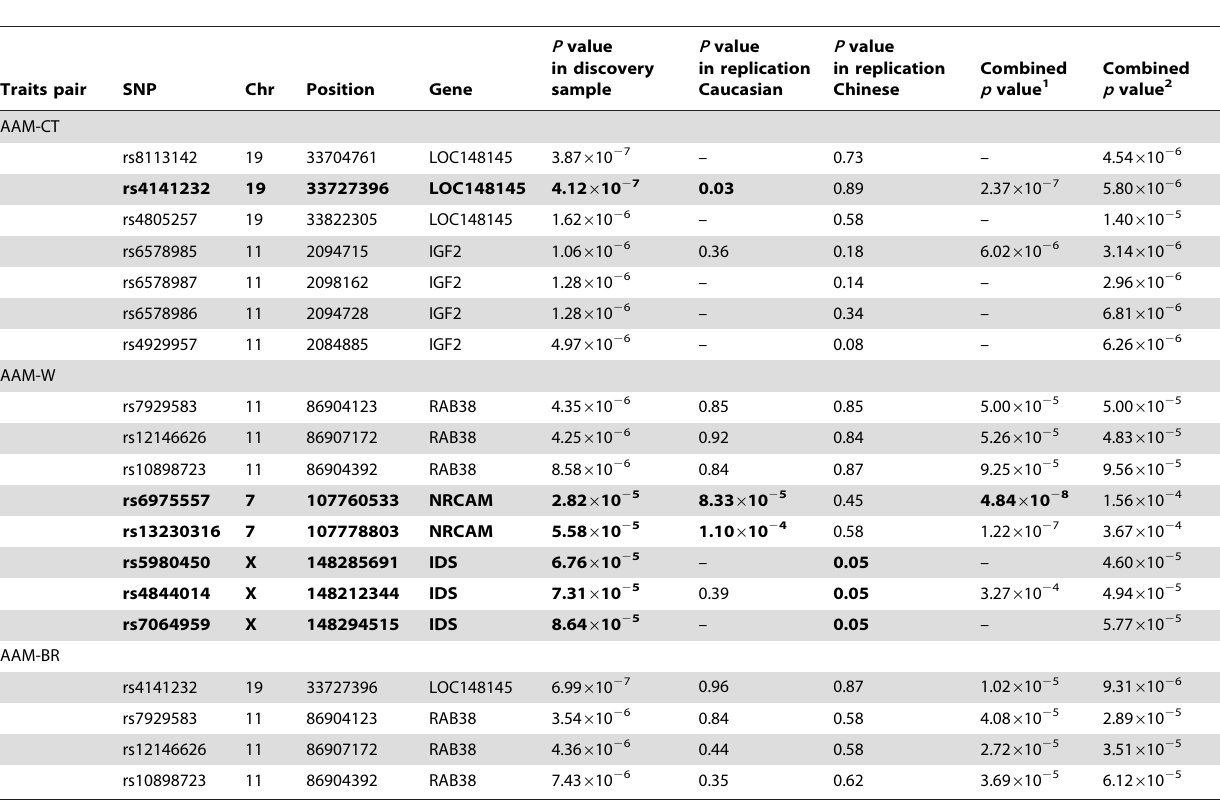
Table 2. Results of bivariate GWAS for AAM and three FNGPs ( p , 10 2 5 in the discovery sample).